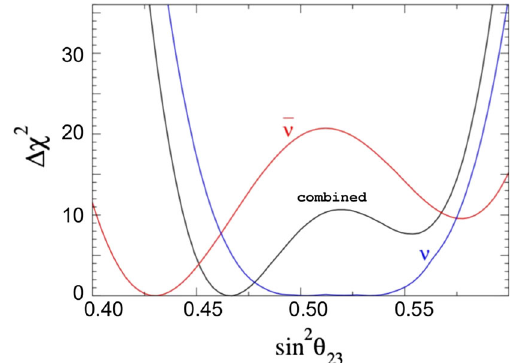
Fig. 12 Estimated sensitivity to Lorentz and CPT violation with atmo- spheric neutrinos in the non-minimal isotropic Standard Model Exten- sion. The sensitivities are estimated by requiring that the Lorentz/CPT- violating effects are comparable in size to those from conventional neu- trino